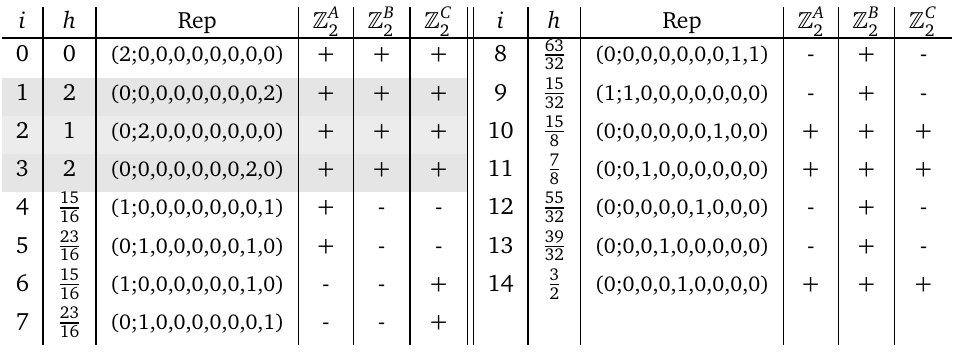
( τ ) . Primaries i = 1,2,3 are the generator of (cid:90) A i subgroup of the center symmetry (cid:90) 2